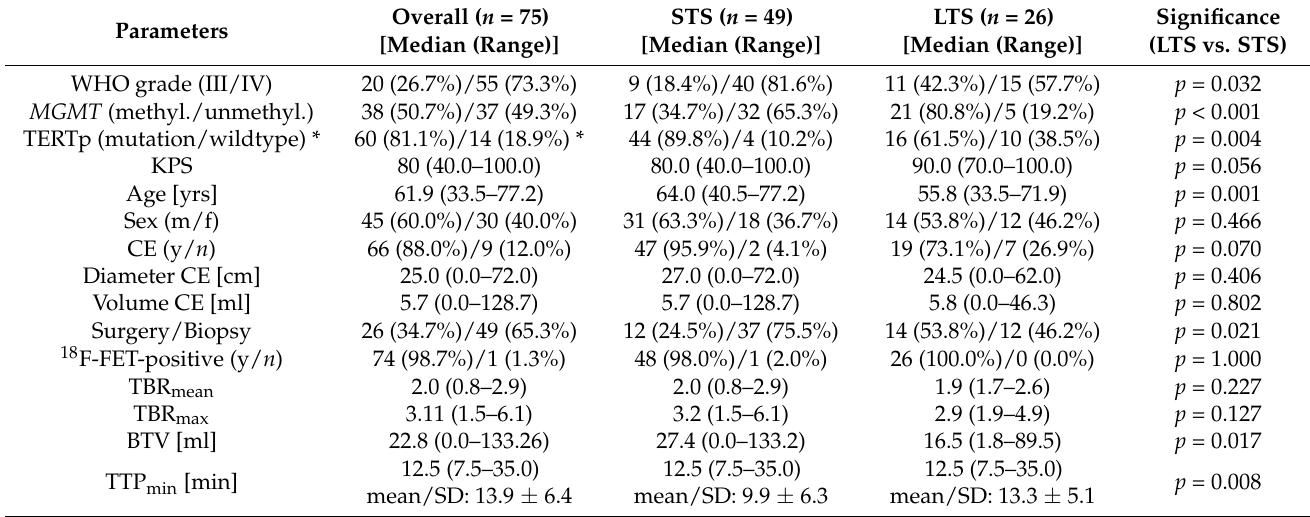
Table 1. Overview and overview differences STS and LTS (15 vs. 36